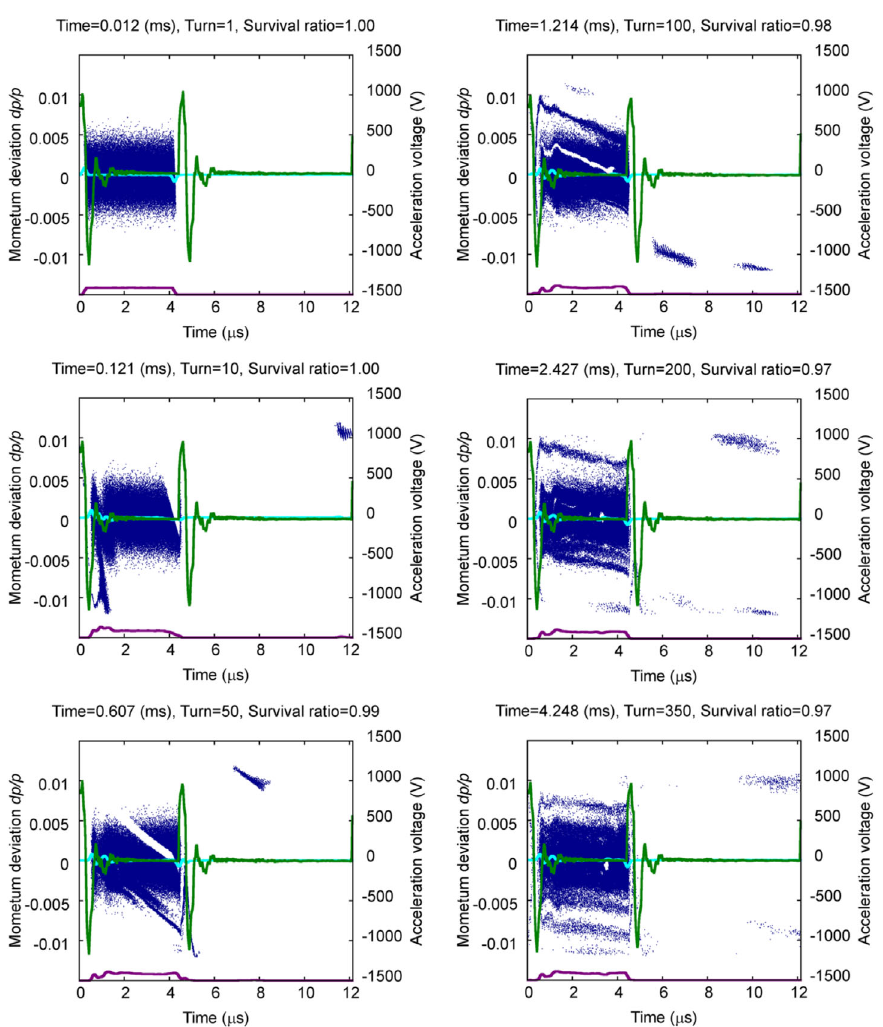
FIG. 5. Snapshots of the beam distribution in the longitudinal phase space in the SBB at the 1st, 10th, 50th, 100th, 200th, and 350th turns, from the top left to the bottom right. The barrier voltage and space-charge-induced voltage are indicated in green and cyan, respectively. The beam intensity profile in arbitrary units is indicated in